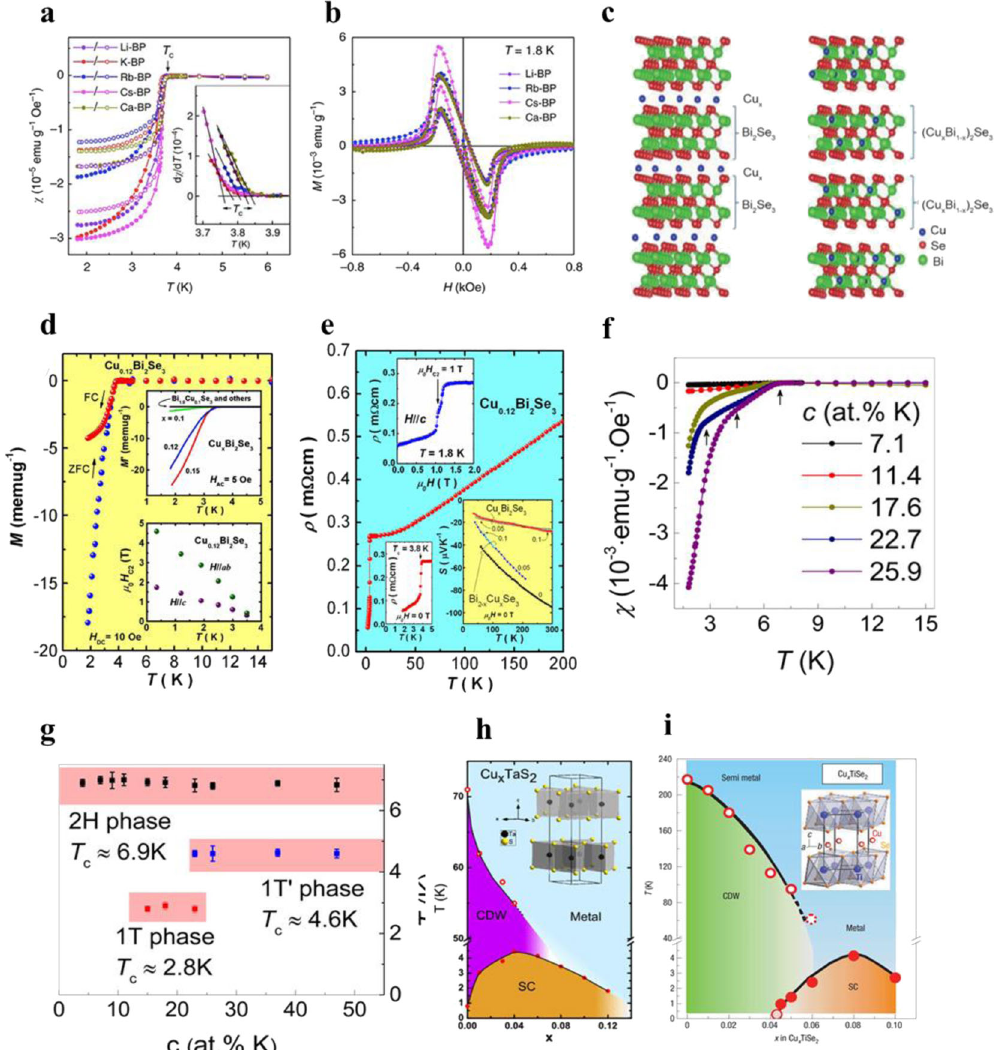
Fig. 7 Intercalation effects on superconductivity and CDW. a Temperature dependence of magnetic susceptibility χ for Li, K, Rb, Cs, and Ca intercalation for BP. Shown are ZFC (solid symbols) and FC (open symbols) measurements for an in-plane magnetic fi eld of 10 Oe. The inset shows how T c was determined for individual samples: it is de fi ned as the sharp change in d χ /d T . b Magnetization M as a function of the magnetic fi eld for intercalated compounds 60 . c Crystal structure of Cu intercalated Bi 2 Se 3 that makes superconducting Cu x Bi 2 Se 3 (left), and random substitution of Cu by replacing Bi atoms making Bi 2-x Cu x Se 3 which is not superconductive (right). 187 d magnetic transport measurements of Cu 0.12 Bi 2 Se 3 , which shows a superconducting transition at 3.8 K. Upper inset: superconductivity occurs only in a narrow window of x in Cu x Bi 2 Se 3 . Superconductivity is not found for x < 0.1 and x > 0.3, or in Bi 2-x Cu x Se 3 . Lower inset: temperature dependence of the superconducting upper critical fi eld of Cu 0.12 Bi 2 Se 3 for the magnetic fi eld applied parallel to the c axis and parallel to the ab plane. 188 . e Resistivity pro fi le of single crystal Cu 0.12 Bi 2 Se 3 with applied current in ab-plane. The lower inset shows that the superconducting transition occurs at ̴ 3.8 K. The upper inset shows the magnetoresistance plot at T = 1.8 K. The second inset shows the zoomed in version of the resistivity plot and the third inset shows the comparison of the Seebeck coef fi cients of Cu x Bi 2 Se 3 and Bi 2-x Cu x Se 3 . 188 f Superconductivity in K intercalated 2H-MoS 2 . g Superconducting phases of K intercalated 2H-MoS 2 at various K concentration 59 . Electronic phase diagram of Cu intercalated TaS 2 and TiSe 2 . Temperature ( T ) vs concentration (x) electronic phase diagram of Cu intercalated h TaS 2190 and i TiSe 2 with inset showing the crystal structure 191 . Panels a , b reprinted with permission from Springer Nature Publications Nature Communications 60 , Copyright (2017), advance online publication 23 February 2017 (https://doi.org/10.1038/ncomms15036, Nature Commun ). Panel c reused with permission from John Wiley and Sons/Wang et al. 187 . Panels d , e reused with permission from American Physical Society/Hor et al. 188 (https://doi.org/ 10.1103/PhysRevLett.104.057001); panels f , g adapted with permission from 59 Nano Lett. 16 , 629 – 636. Copyright (2016). American Chemical Society; panel h reused with permission from American Physical Society/Wagner et al. 190 (https://doi.org/10.1103/PhysRevB.78.104520); panel